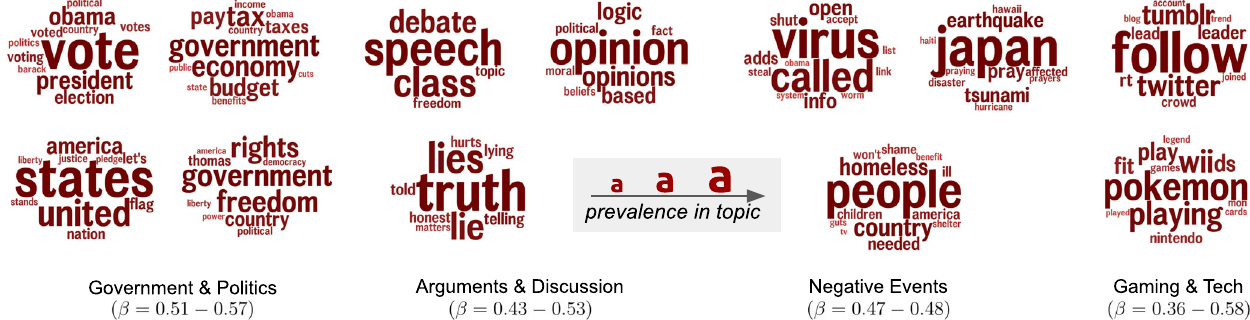
Fig. 6 Language associated with higher opioid death rates. Topics longitudinally predictive of higher opioid death rates: yearly change in language (2014 – 2015, 2015 – 2016) positively associated with future year change in opioid death rates. Individual topics (clusters of semantically related words) are represented by their 15 most prevalent words (larger is more prevalent). Association ( β ) is the coef fi cient from standardized multiple linear models, adjusting for prior change ( p < 0.05; Benjamini – Hochberg adjusted for false discovery